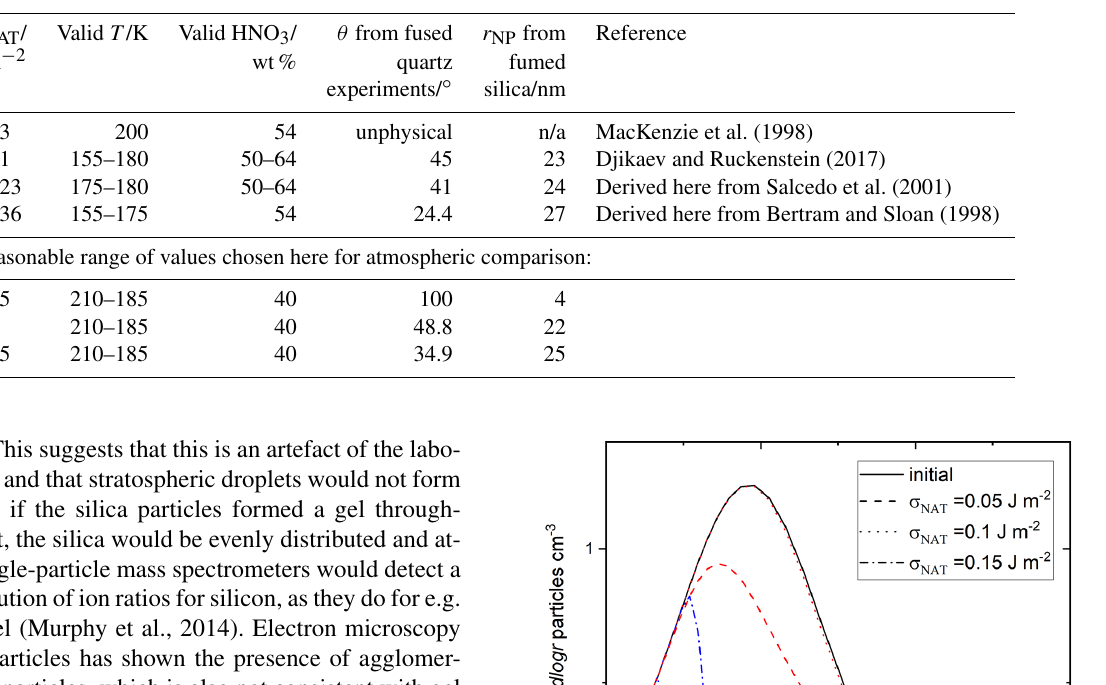
Table 2. Surface energy ( σ NAT ) values in the literature or derived from the literature nucleation rate data. Note that n/a stands for not applicable.